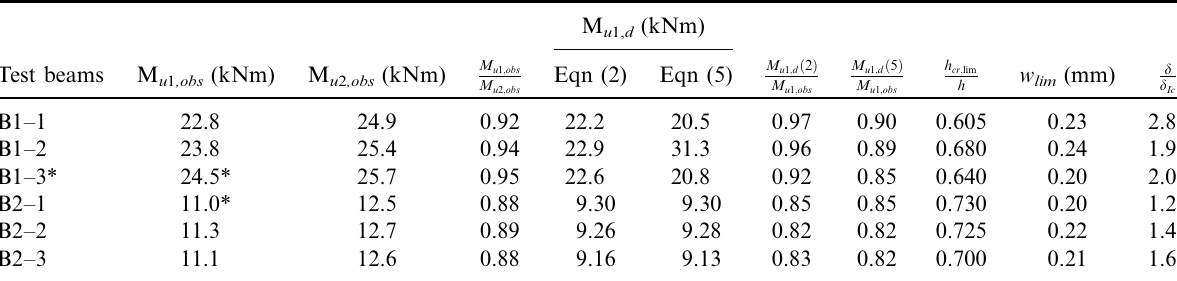
Table 3. The comparison between numerical and measured characteristics of tested